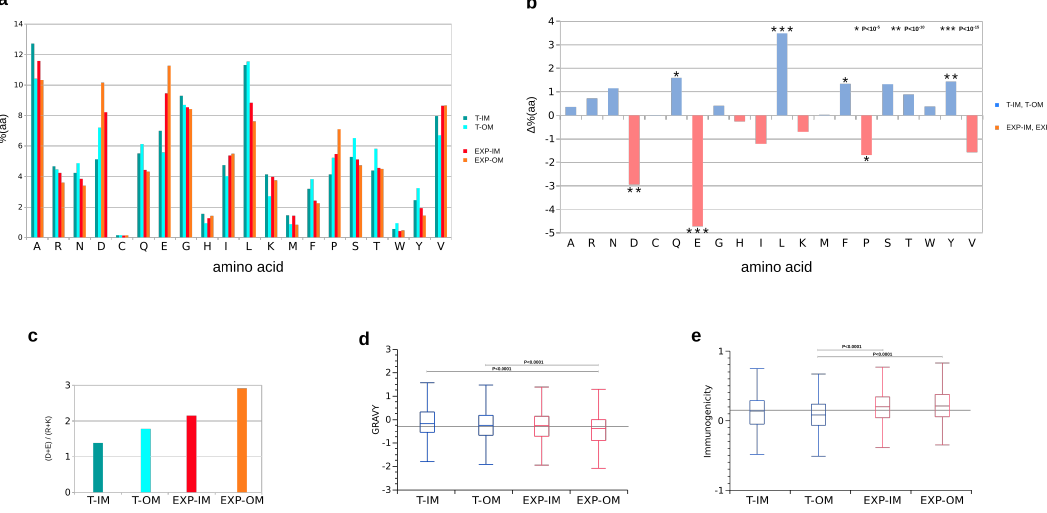
( a ) Amino acid composition of T-IM, T-OM, EXP-IM, EXP-OM classified peptides. ( b ) Differences in amino acid composition ( ∆ %) between trans membrane (T-IM + T-OM) and exposed (EXP-IM + EXP-OM) classified peptides. Positive values (blue bars) indicate amino acids over-represented in trans membrane peptides, while negative values (red bars) indicated amino acids over-represented in exposed peptides. Data were compared by Chi-Square test ( p ≤ 10 − 5 ). ( c ) Ratio between total number of negatively (D + E) and positively charged residues (R + K). ( d ) Comparison of Gravy index and ( e ) Immunogenicity calculated for T-IM, T-OM, EXP-IM, EXP-OM classified peptides (ANOVA and Tukey’s test; p ≤ 10 − 3